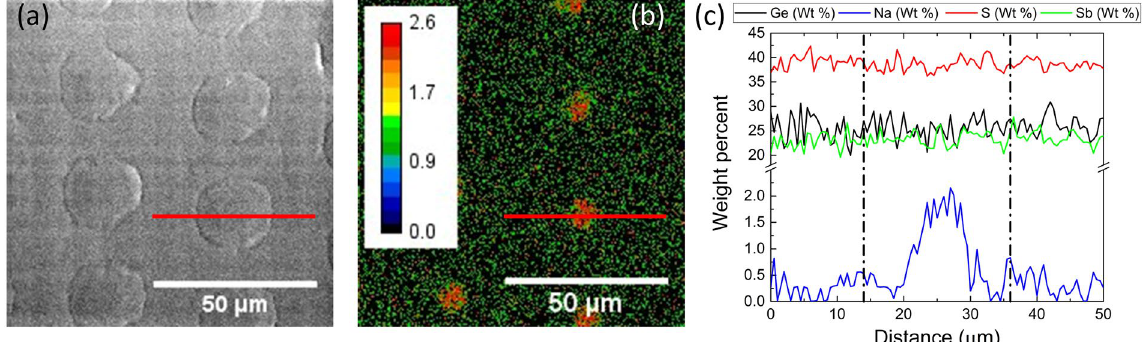
Figure 2. BSE image of patterns imprinted on the glass surface ( a ), map of the Na distribution in wt% measured by WDS ( b ), and elemental profile (wt %) of Ge, S, Sb and Na across the shown (in b) red line, vertical dash lines represent the edges of the pattern ( c ).